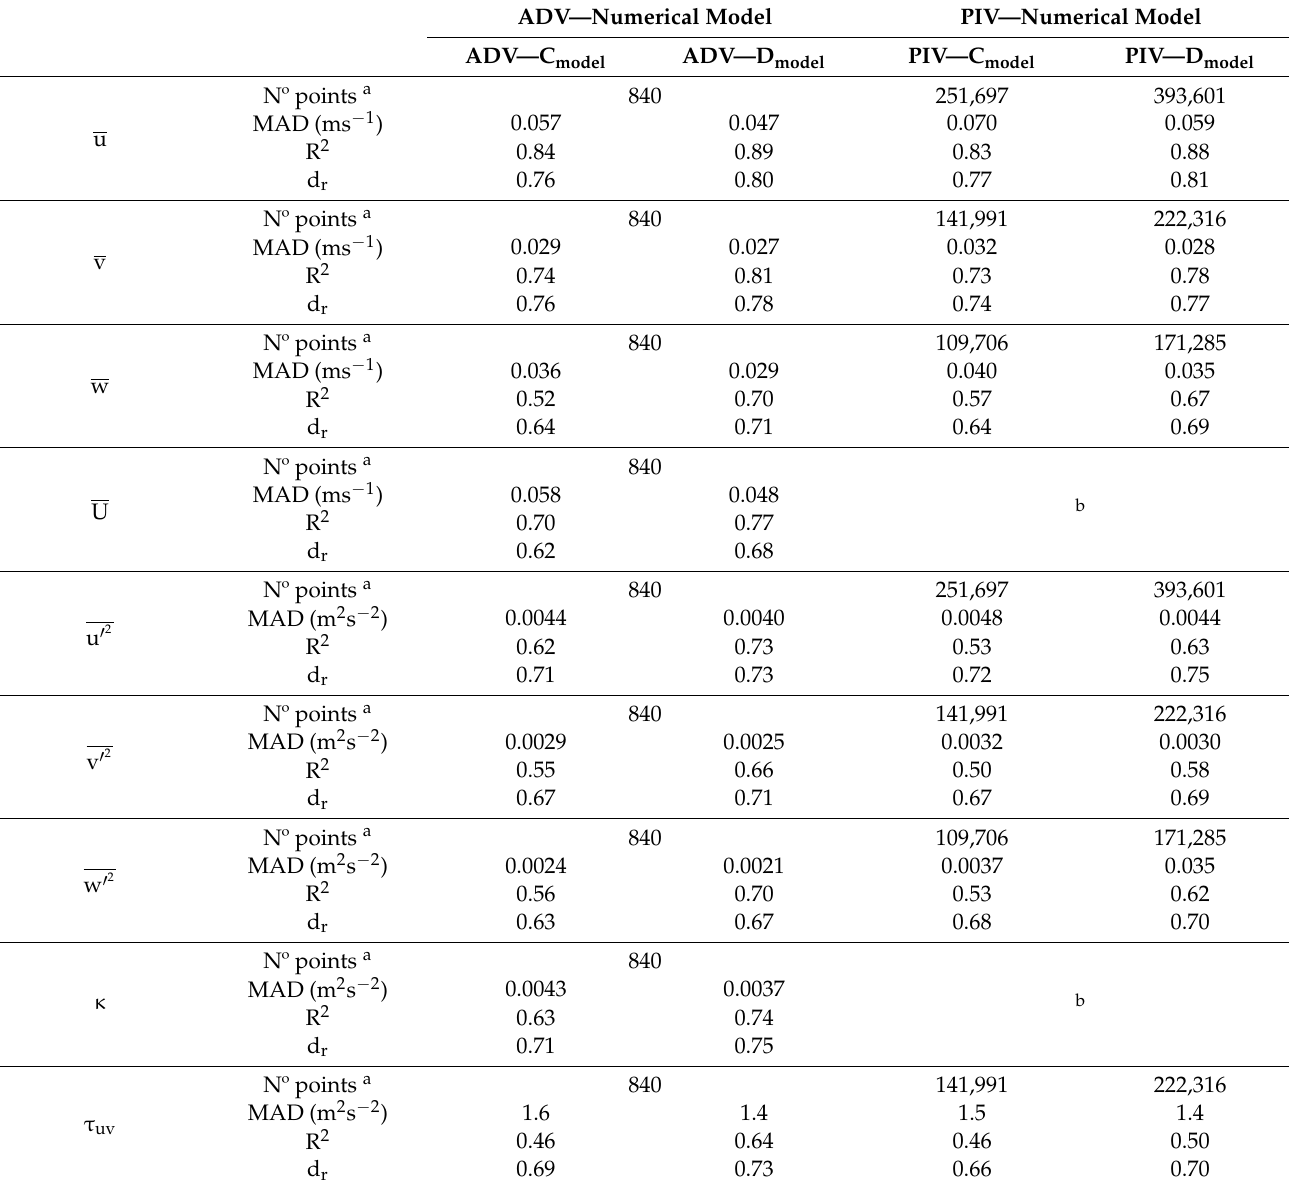
Table A1. Comparison between numerical model results and measurements for meshes C model and D model. ADV—Numerical Model